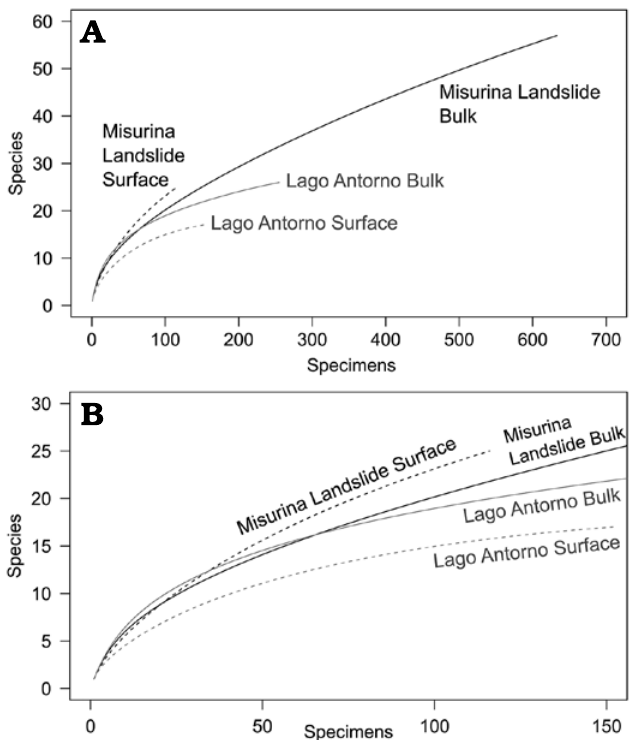
Fig. 3. Rarefaction curves of surface and bulk samples from Misurina Landslide and Lago Antorno. A . Complete curves. B . Detailed view.